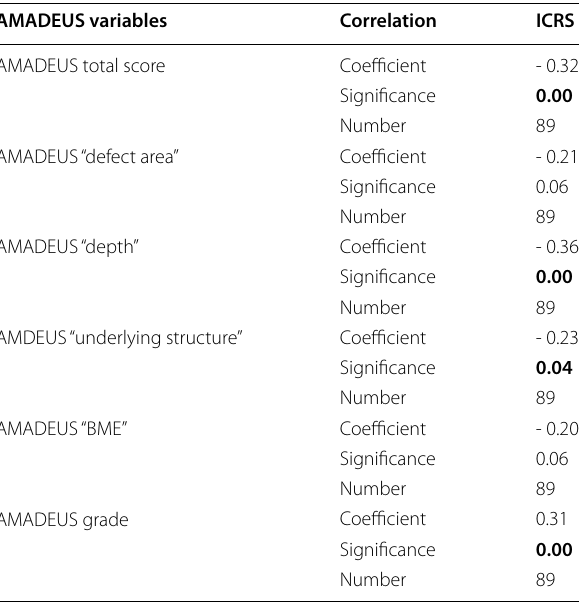
Table 4 Spearman correlation analysis of dependent AMADEUS subscore items with ICRS